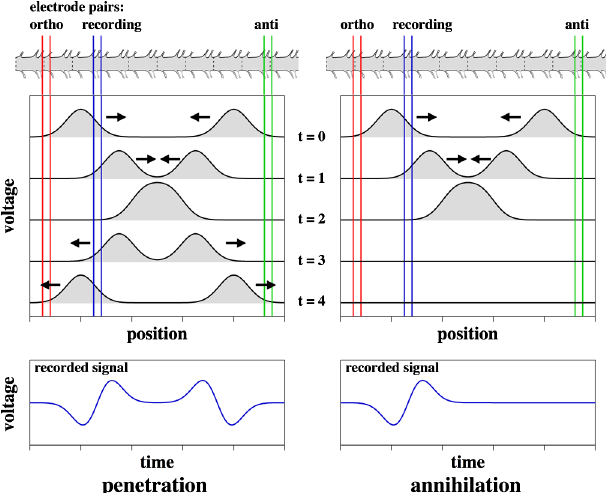
FIG. 4. A schematic representation of the different steps of the collision experiment at times t 0 , t 1 , t 2 , and t 3 . The action potentials (AP) are generated at t 0 by simultaneous stimulation in both ends of the ventral cord; the orthodromic AP reaches the recording electrodes at t 1 ; the APs collide at t 2 ; the antidromic AP reaches the recording electrodes at t 3